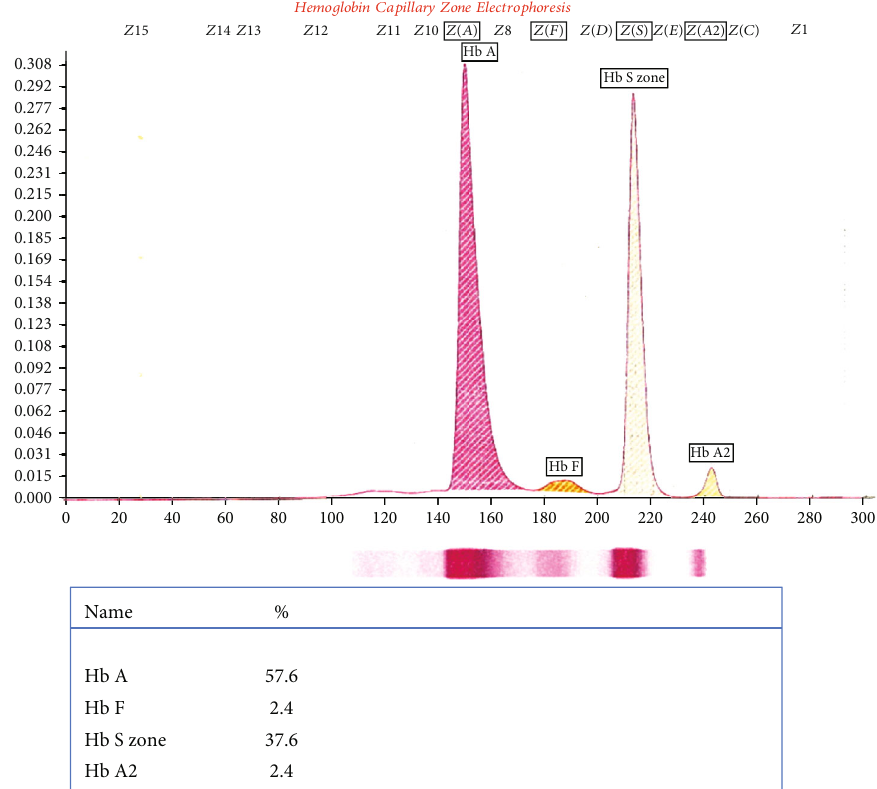
Figure 3: Hemoglobin electrophoresis showed the presence of 57.6% hemoglobin A (HbA), 37.6% hemoglobin S, 2.4% hemoglobin A2, and 2.4% hemoglobin F, which was compatible with the diagnosis of sickle cell trait.